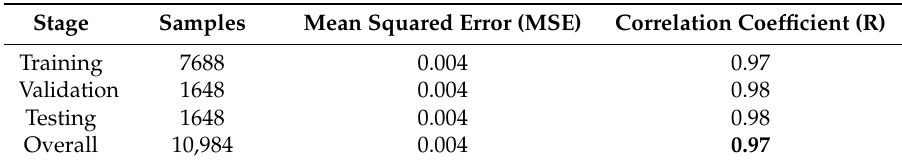
Table 2. Statistical results of Model 2 showing the number of samples, mean squared error (MSE) and correlation coefficient (R) for the training, validation and testing stages as well as the overall model.